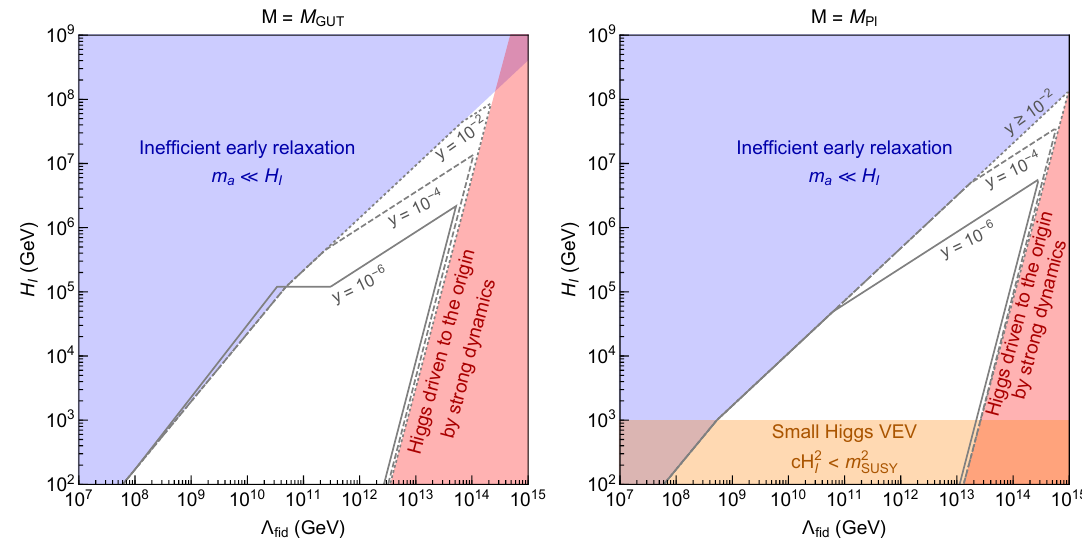
Figure 3 . Parameter space for the in(cid:13)ationary Hubble scale H I and the (cid:12)ducial con(cid:12)nement scale (cid:3) (cid:12)d de(cid:12)ned in eq. (3.7) given f a = 3 (cid:2) 10 9 GeV, m ~ g = m SUSY = TeV, and (cid:30) i = M . The left (right) panel is for the cuto(cid:11) scale M = M GUT ( M Pl )